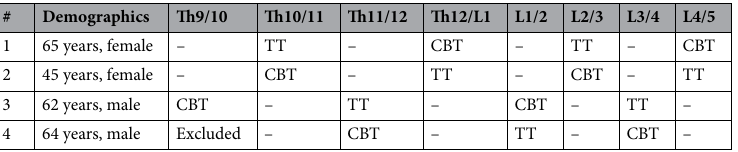
Table 1. Overview on the spinal segments used for this study and the pedicle screw rajectories used for instrumentation. TT traditional trajectory, CBT cortical bone